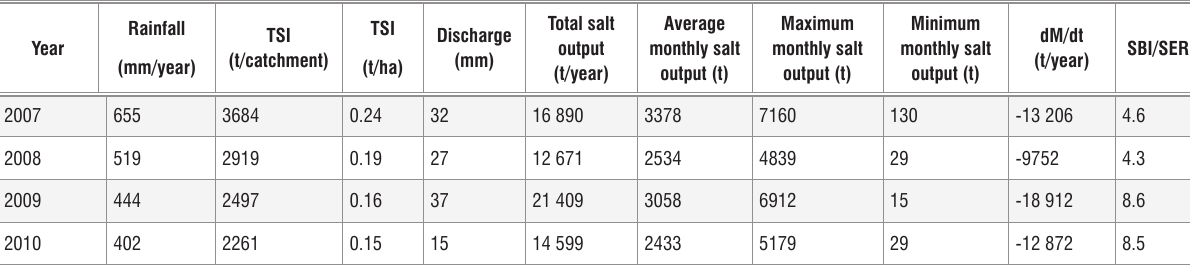
Components of the catchment salt